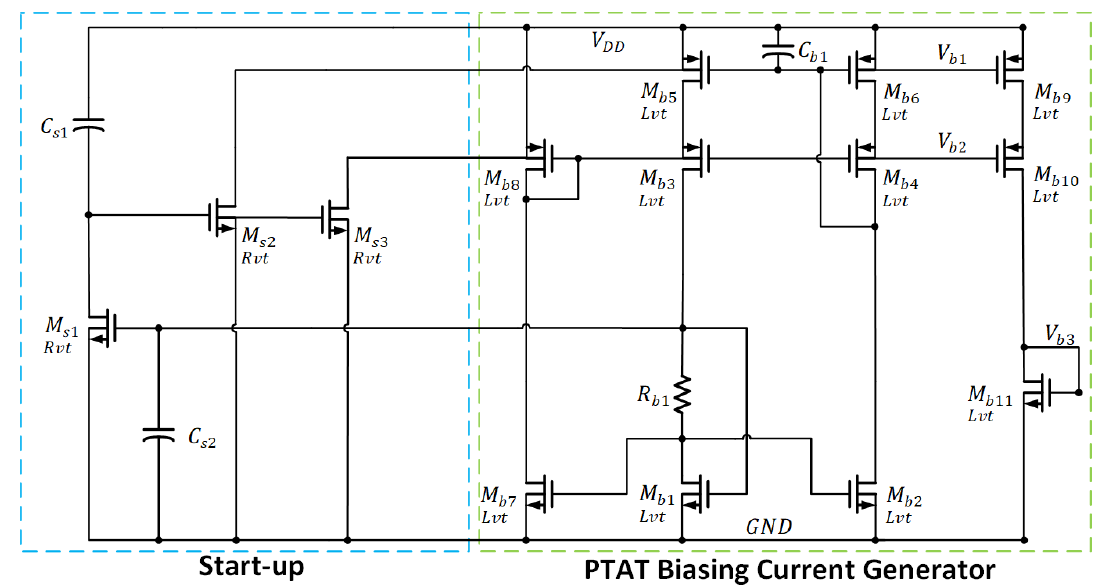
Figure 7. Biasing Circuit and Start-up Circuit.